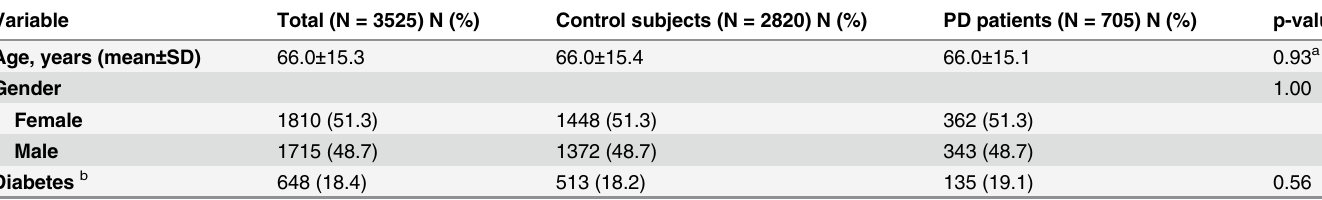
Table 1. Clinical characteristics of study subjects with and without PD (N = 3525).